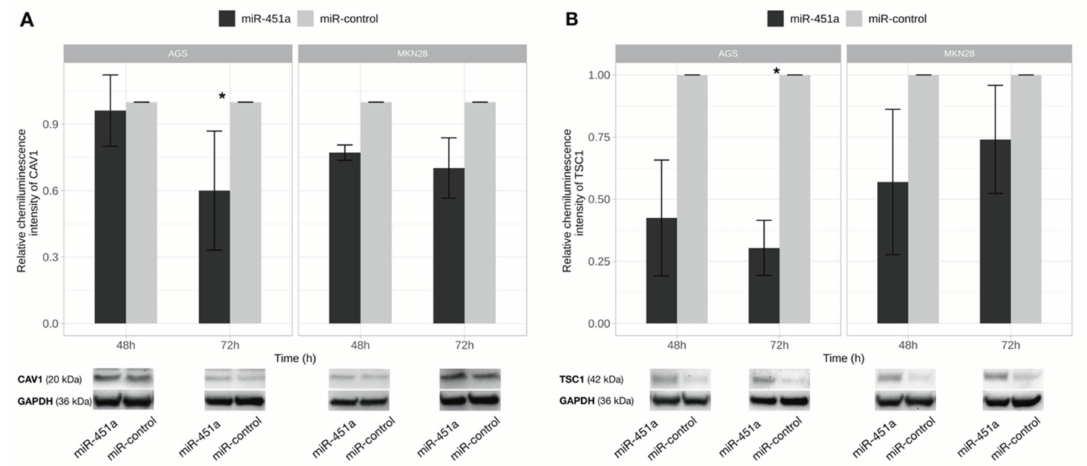
Figure 9. CAV1 and TSC1 proteins level changes after exogenous up-regulation of miR-451a expression. CAV1 ( A ) and TSC1 ( B ) protein expression comparison 48 h and 72 h after transfection in AGS and MKN28 cell cultures transfected with miR-451a and miR-control. Significant CAV1 and TSC1 proteins’ level decrease was determined 72 h after transfection in AGS cell culture. Representative pictures of CAV1 and TSC1 proteins signals detected by Western Blot presented at the bottom of a figure (* p < 0.05). Data from three independent